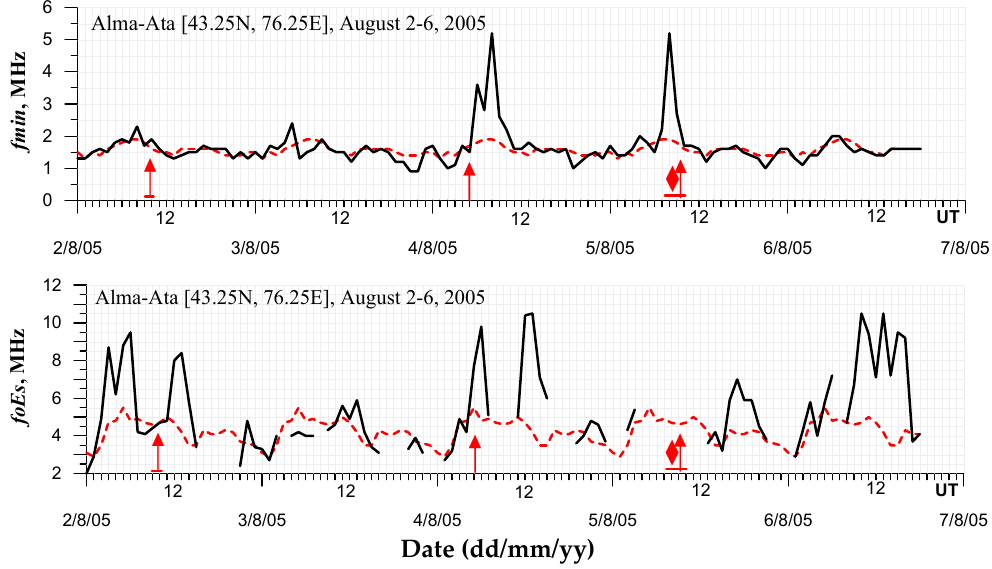
Figure 11. Variations of fmin and foEs for 2–6 August 2005.